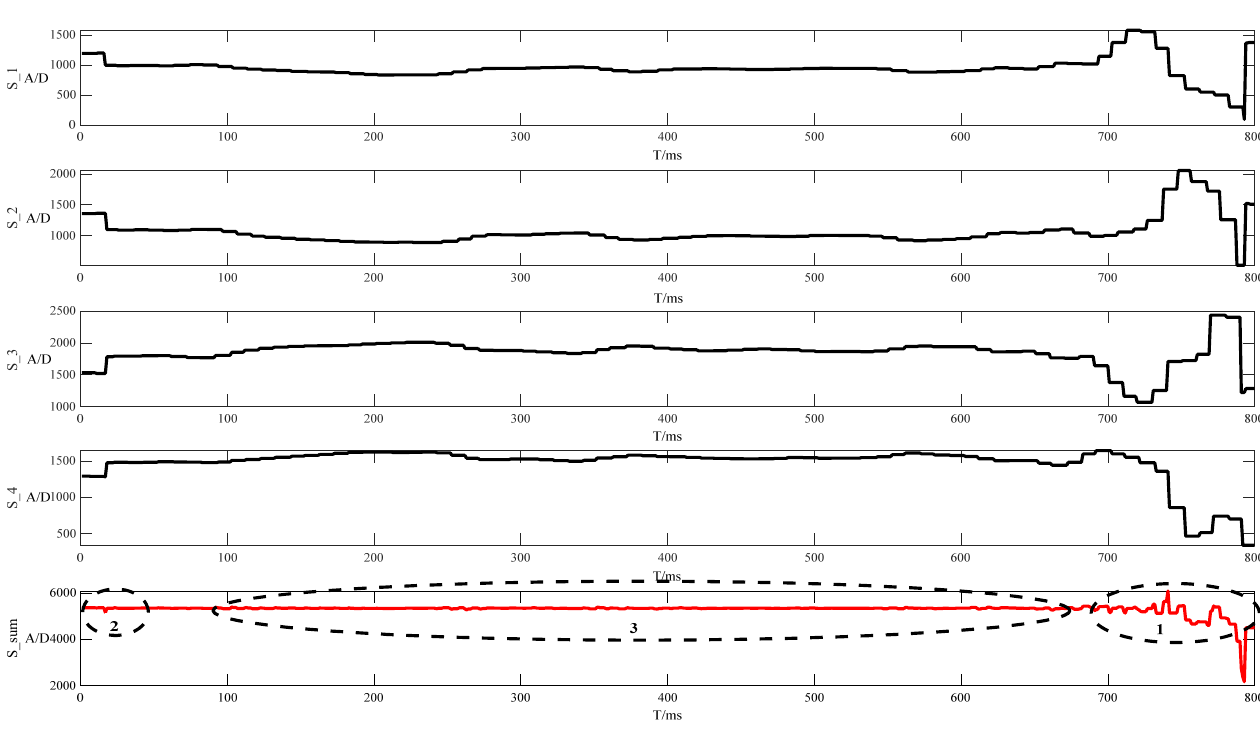
Figure 7. Array of the sliding window.